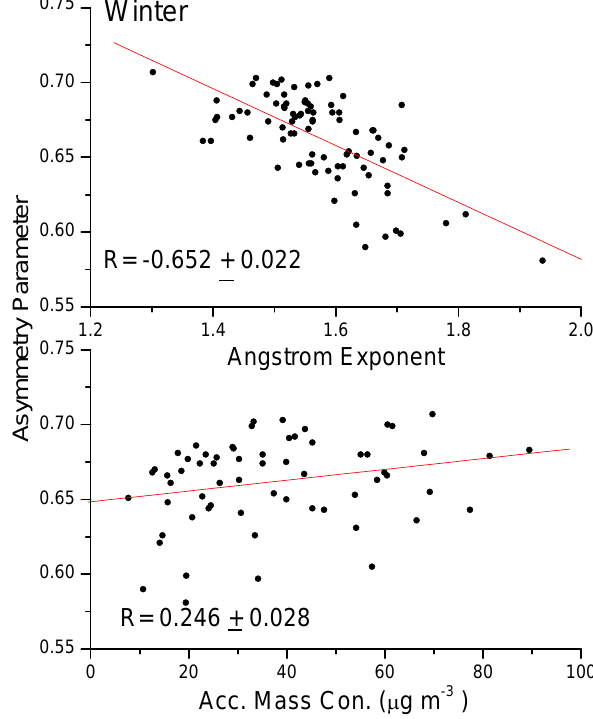
Fig. 3. Variation of asymmetry parameter ( g ) with accumulation mode concentration (in µgm − 3 ) and Angstrom exponent ( α) during winter